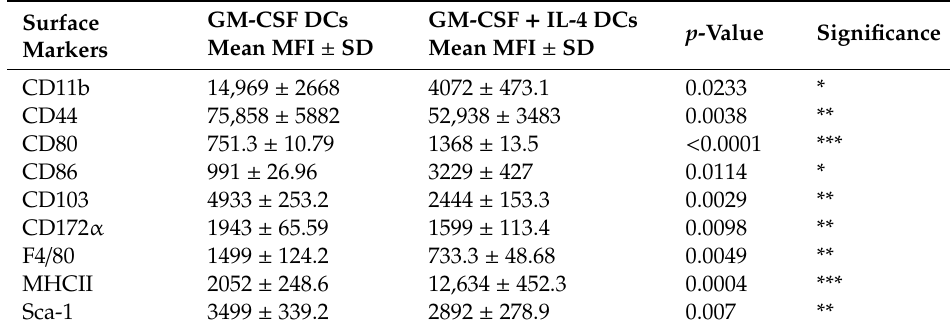
Table 2. Comparison between the expression levels of phenotypic markers, chemokine receptors and activation markers on CD11c + cells.